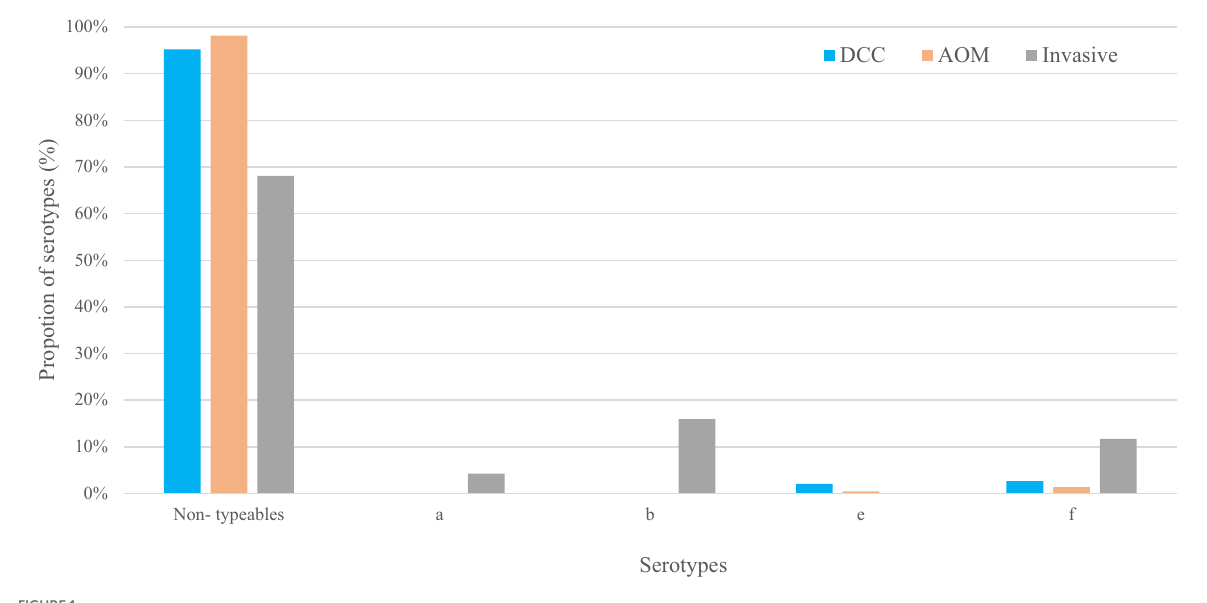
FIGURE 1 Non-typeable and typeable of Haemophilus influenzae in the carriage (AOM and DCC) and invasive group. Overall proportions of circulating serotypes in the carriage groups AOM (in orange) and DCC (in blue) as well as in the invasive group (in grey) detected in strains collected during the period 2016– 2018 for the carriage group and 2015–2018 for the invasive group.